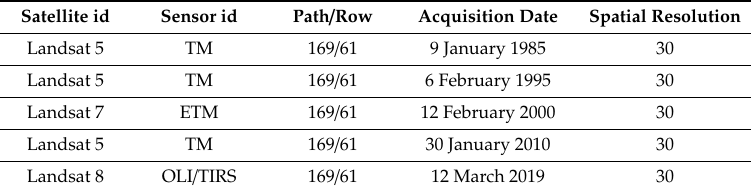
Table 1. Details of acquired satellite images.